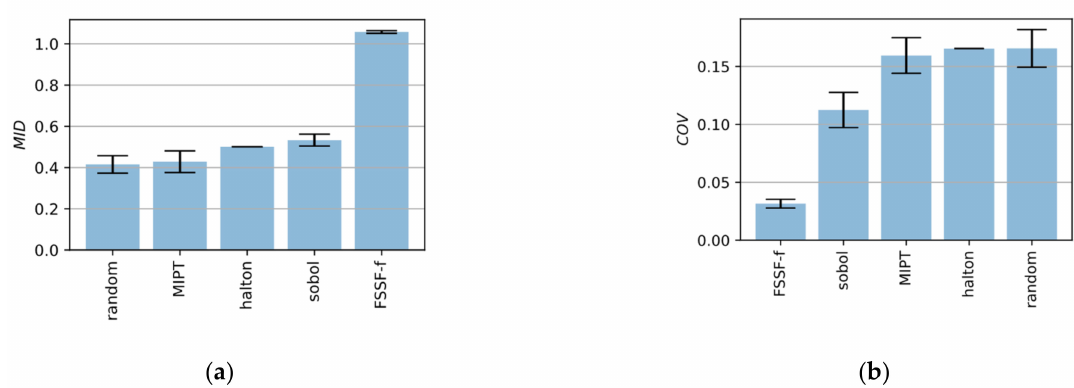
Figure 8. Benchmark of different sequential space-filling methods for 10-dimensional space. Blue bars show the mean value of 10 different designs. Black whiskers show the minimum and maximum values. ( a ) minimum intersite distance; ( b ) cover